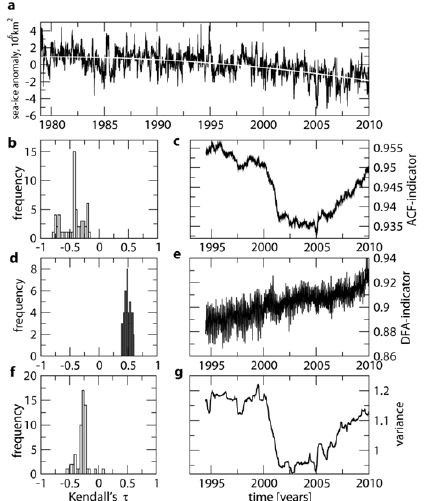
Fig. A6. Search for signals of destabilisation in equivalent sea-ice extent. (a) Equivalent sea-ice extent index (as in Fig. A2) show- ing the quadratic downward trend that is removed prior to calculat- ing the instability indicators. Right panels show example indicators from (c) autocorrelation function (ACF), (e) detrended fluctuation analysis (DFA) and (g) variance; results are plotted at end of a slid- ing window of length half the series. Left panels show histograms of the Kendall statistic for the trend in the indicators when varying the sliding window length from 1/4 to 3/4 of the series: (b) ACF- indicator; (d) DFA-indicator; (f)